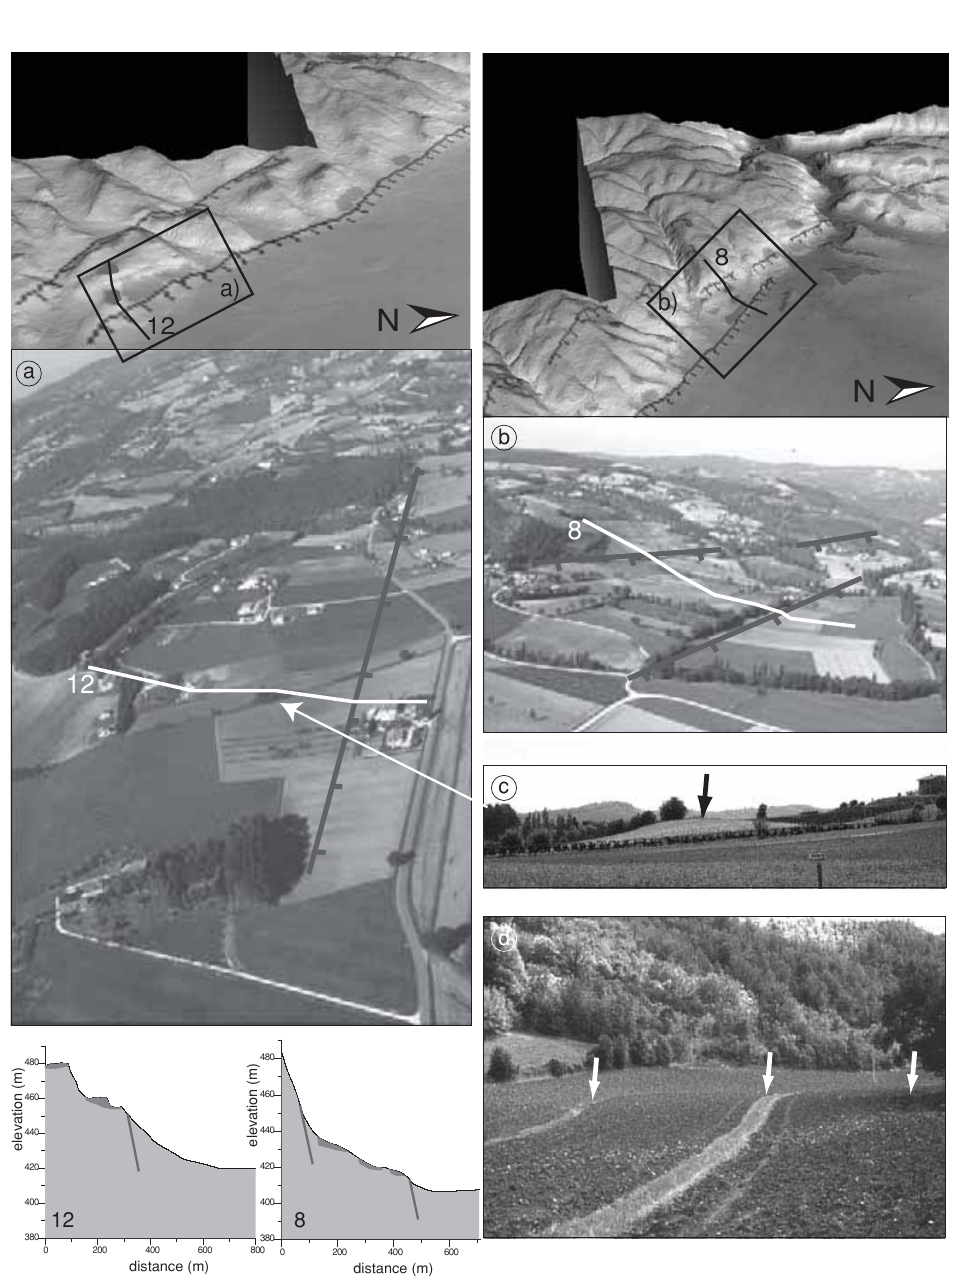
Fig. 12a-d. 3D view of some paleosurfaces and scarps, from 5 m resolution DEM, along with their aerial pho- tograph view (a and b) and their topographic profiles (12 and 8). c) Landscape photograph detail of a paleo- surface of fig. 12a. d) Landscape photograph of a scarp crossing a recent alluvial fan (see fig. 11 for the loca-